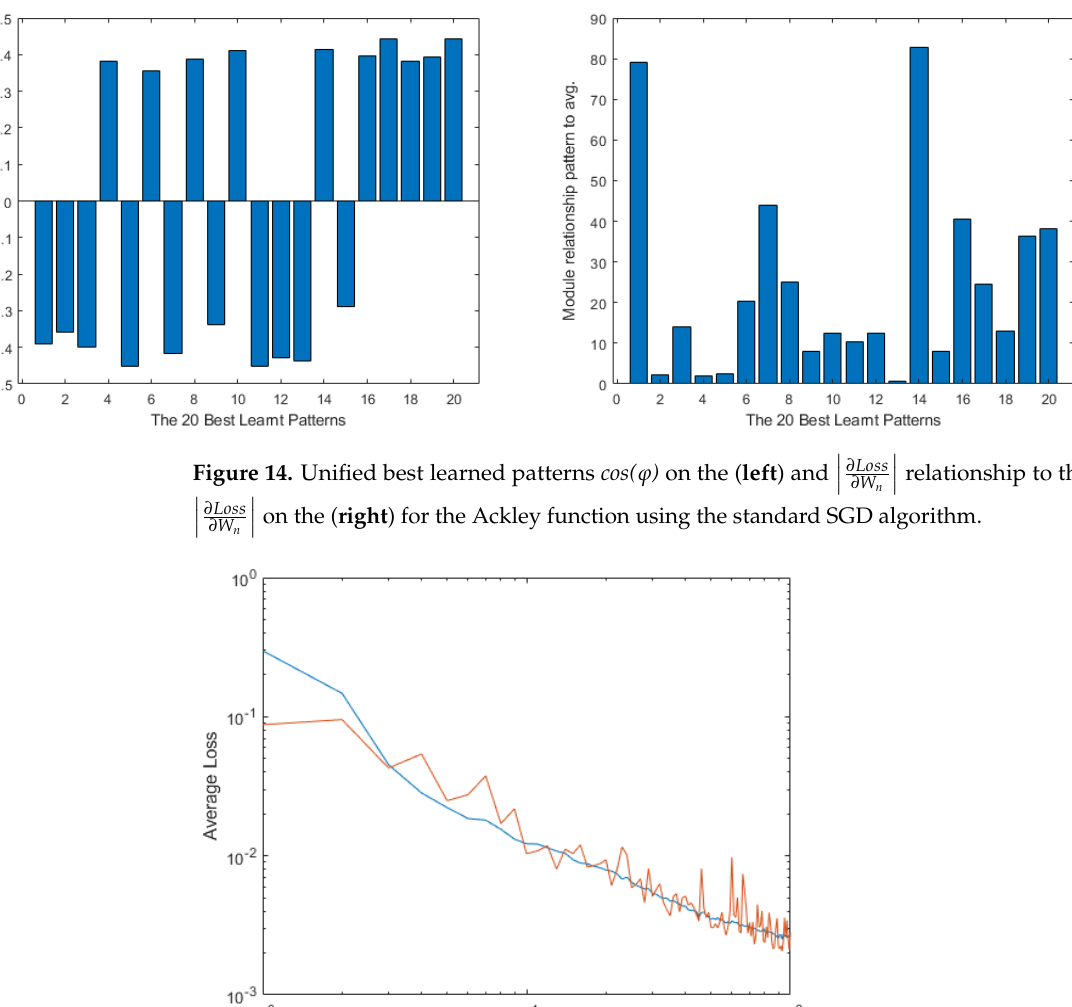
| 𝜕𝐿𝑜𝑠𝑠 | on the ( right ) for the Ackley function using the standard SGD algorithm. 𝜕𝑊 𝑛